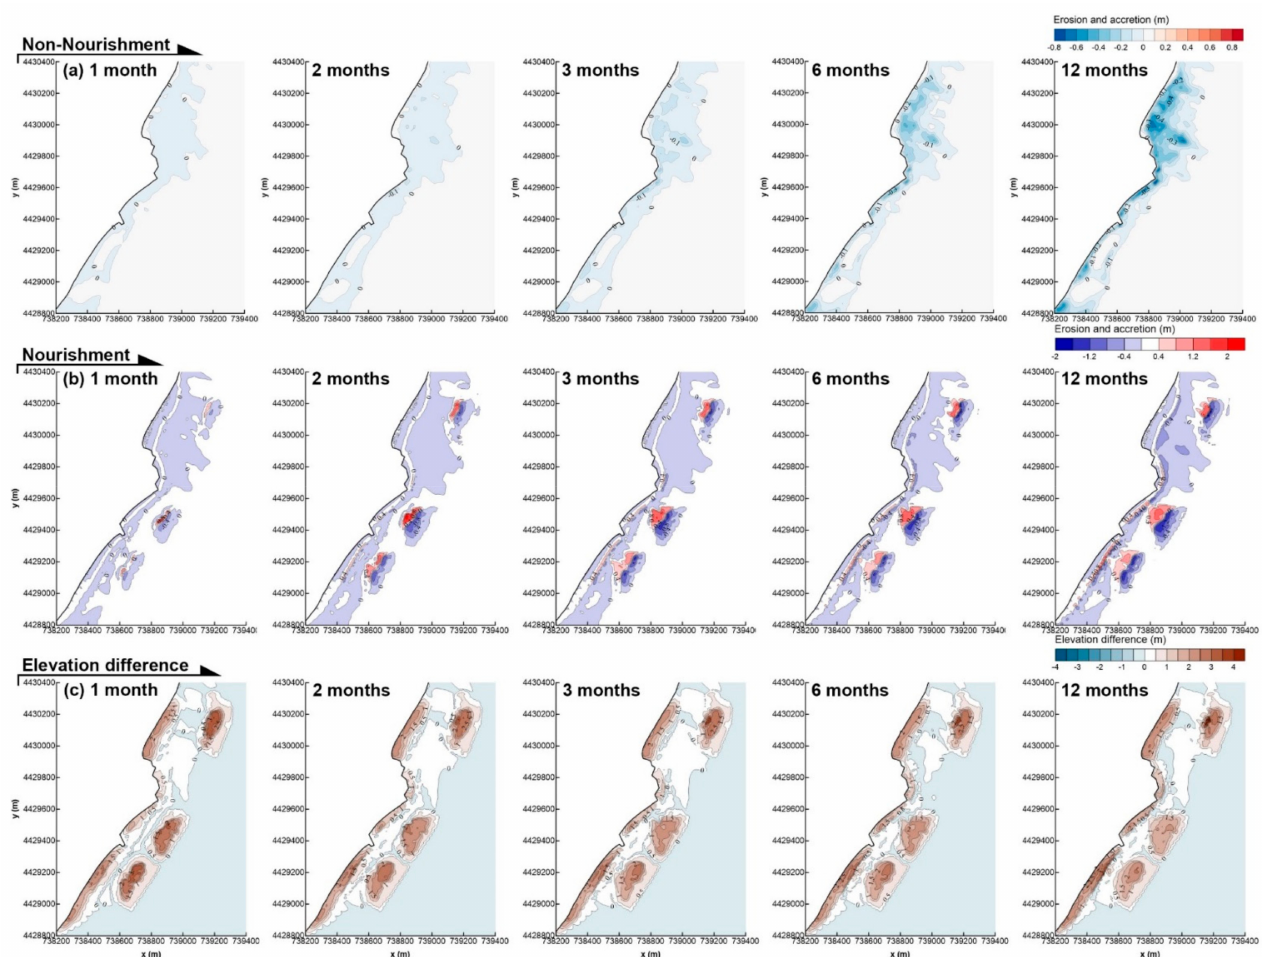
Figure 10. ( a ) Model predicted morphological erosion and accretion without the beach nourishment and ( b ) with the beach nourishment, and ( c ) the elevation difference between with and without beach nourishment 1, 2, 3, 6, and 12 months after the start time of the beach